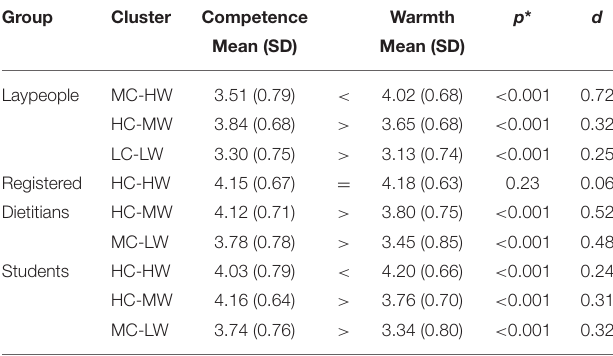
TABLE 2 | Competence and warmth means for each